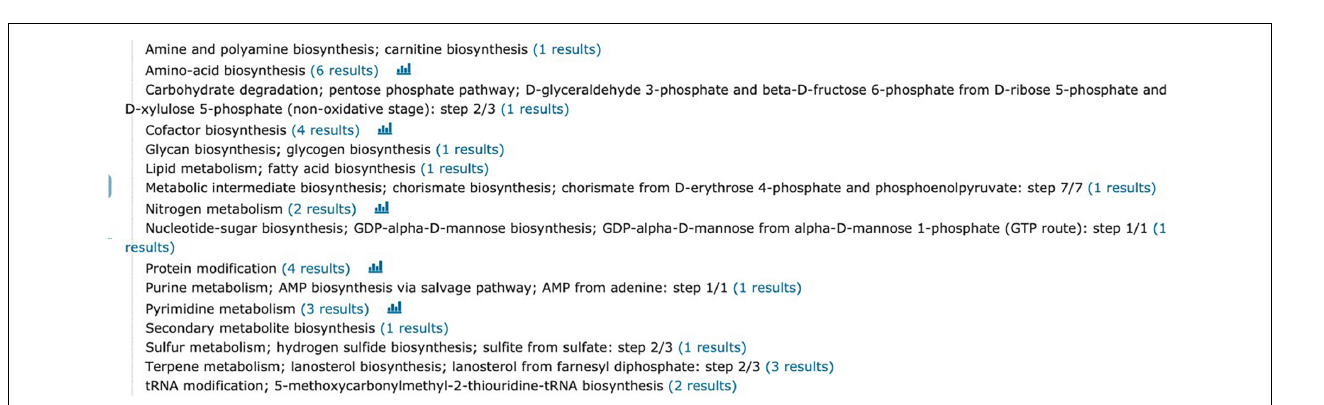
FIGURE 5 | Gene Ontology (GO) function annotation of the identified proteins.